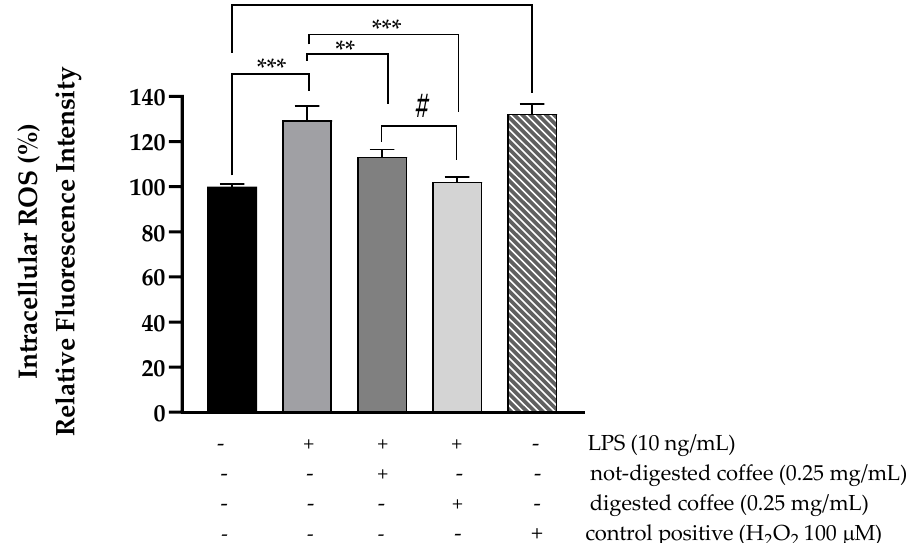
Figure 4. Evaluation of intracellular ROS level in HT-29 cells treated with not-digested and digested coffee after LPS treatments. Intracellular ROS levels were assessed by H 2 DCF-DA assay in LPS- stimulated HT-29 cells treated for 48h with digested and not-digested coffee samples (0.25 mg/mL) compared with untreated cells. H 2 O 2 (100 µ M) was used as positive control. Mean ± SD of three independent experiments were plotted on the graph. Differences were considered significant when p -value ≤ 0.05, p -value ≤ 0.01 and highly significant when p -value ≤ 0.001. * p ≤ 0.05, ** p ≤ 0.01, and *** p ≤ 0.001 versus untreated control (calculated as fold-change relative to untreated cells, arbitrarily set at 100%) and/or LPS-stimulated cells; # p ≤ 0.05, ## p ≤ 0.01, and ### p ≤ 0.001 not-digested coffee versus digested coffee.